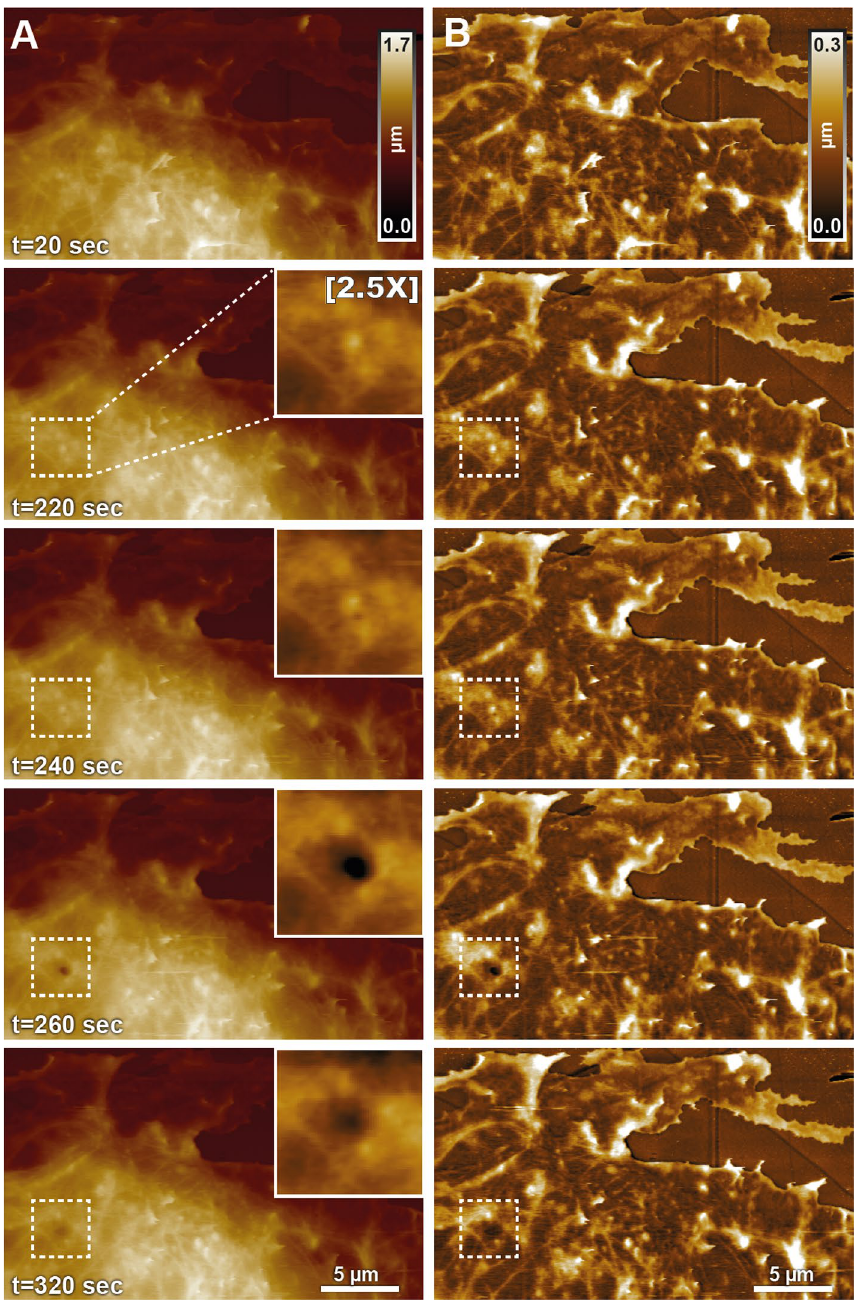
Figure 5. Live-cell time-lapse imaging. ( A ) Stills extracted from a time-lapse series depicting the peripheral region (27 × 16 µm 2 ) of a fibroblast cell recorded at 450 × 270 pixels and 14 Hz line frequency (20 s/frame) display the dynamic reorganization of the submembranous cortical cytoskeleton. Enlargements of the boxed areas shown in the corresponding images in ( A , B ) highlighting a transient circular depression in the cell membrane, consistent with an endocytosis event. ( B ) The time-lapse series shown in ( A ) was further processed (see “Methods”) to highlight the cortical cytoskeleton. Individual panels were generated using ImageJ 1.52e (https:// imagej. nih. gov/ ij/ index. html) and/or Matlab 2020b (https:// it. mathw orks. com/ produ cts/ matlab. html). Final figure was assembled, edited, and rendered with Adobe Creative Cloud suite (https:// www. adobe. com/ creat ivecl oud.